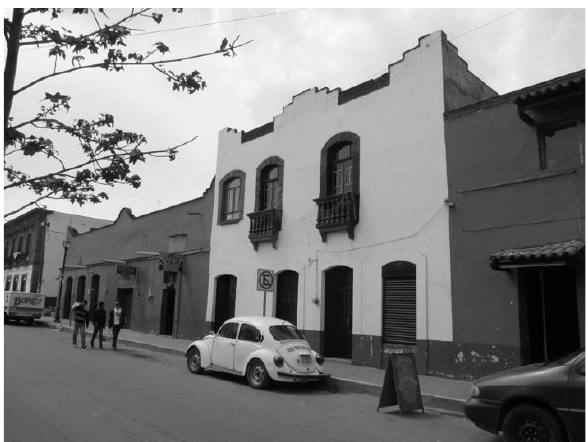
Figure 6. Two-story housing typologies. (Source: DSRO).